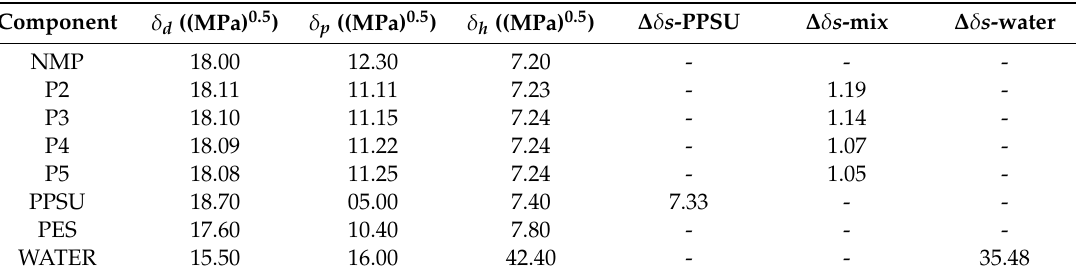
Table 2. Solubility parameters and their di ff erence ((MPa) 0.5